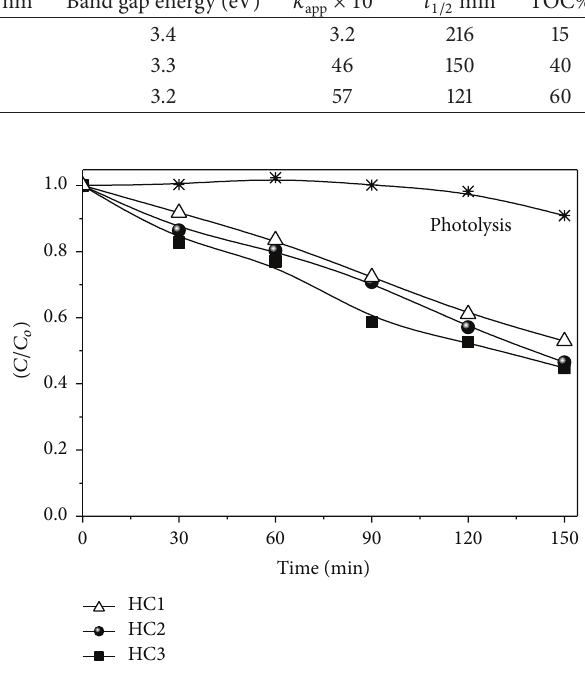
Figure 8: Relative concentrations ( 𝐶/𝐶 𝑜 ) versus irradiation time ( 𝑡 ) of 2,4-D photodegradation.